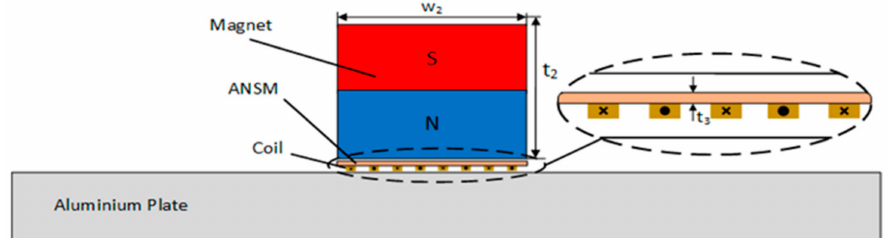
Figure 8. Schematic diagram of the finite element model for surface wave EMATs after adding ANSM. After simulation, the amplitudes of in-plane and out-of-plane displacements of surface wave are as follows: u m = 21.90 × 10 − 8 mm, v m = 7.32 × 10 − 7 mm; compared with the